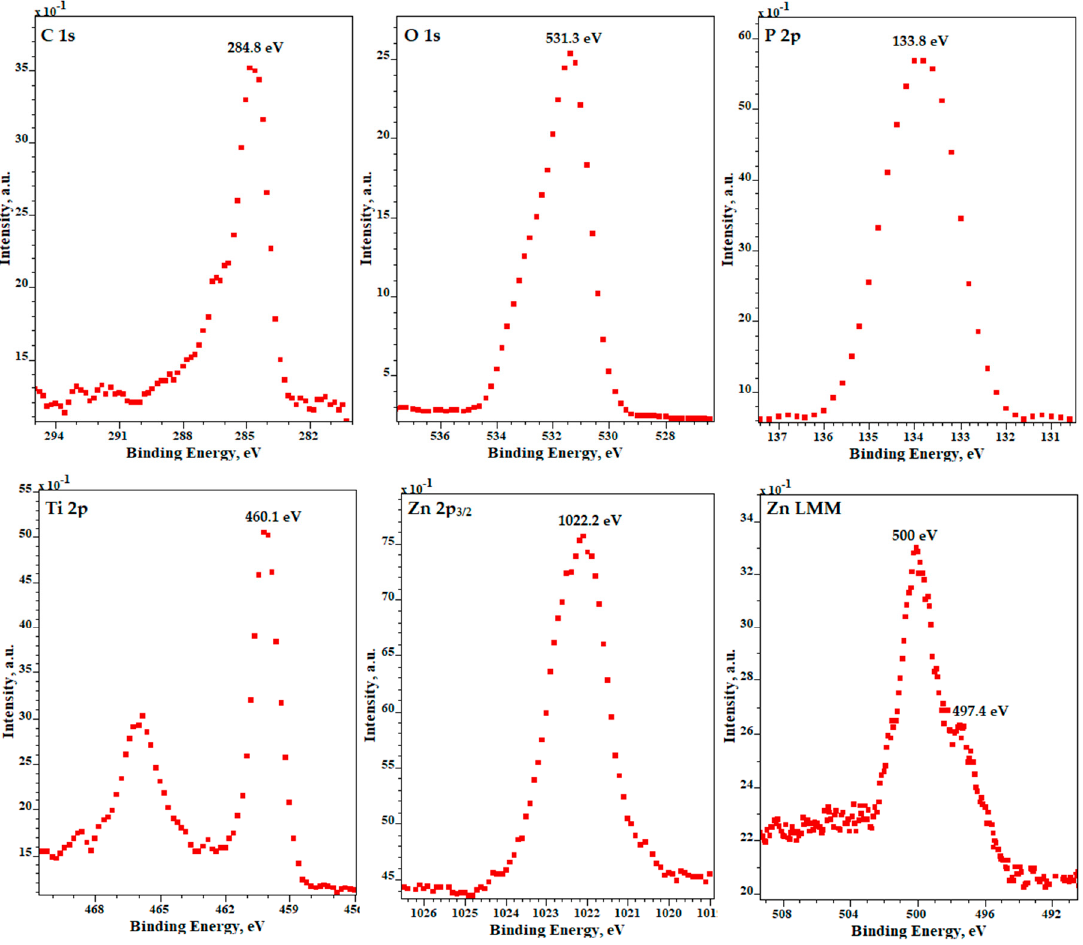
Figure 7. XPS results for samples after PEO processing obtained in electrolyte composed of Zn(NO 3 ) 2 ·6H 2 O in H 3 PO 4 at a concentration of 600 g/L and at a voltage of 450 ± 46 V with pulsation frequency of 300 Hz.